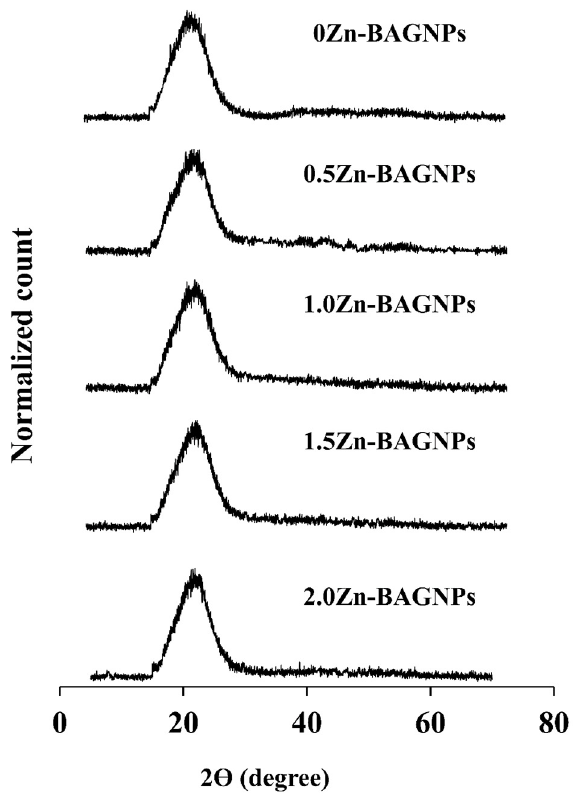
Figure 3. XRD spectra of Zn-BAGNPs with an increasing amount of Zn.